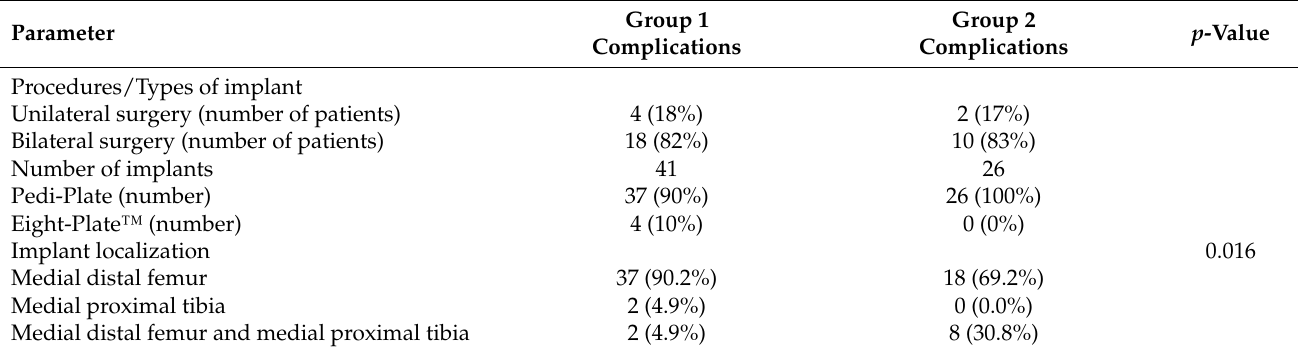
Table 3. Types of implant and implant localization.